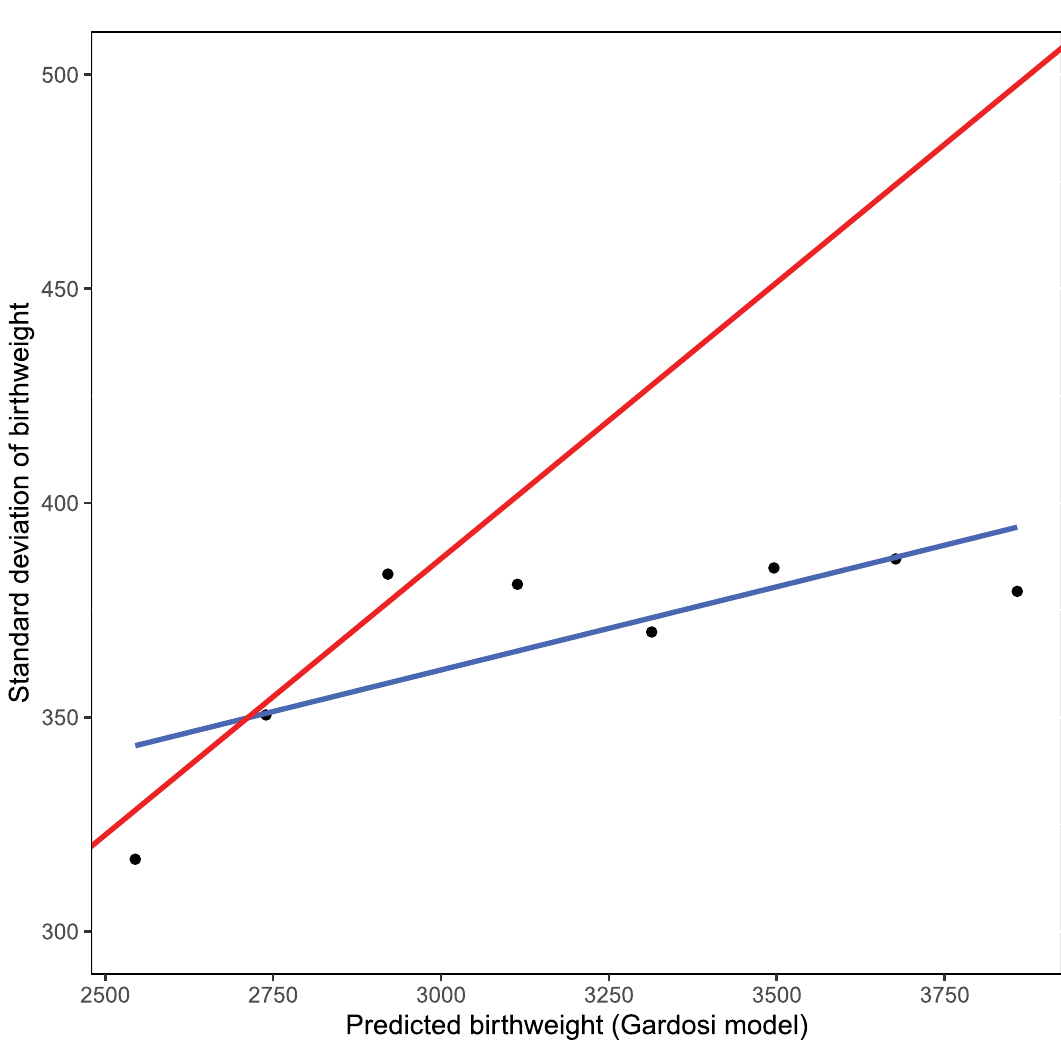
Fig 2. Empirical and Gardosi model based standard deviation of birthweight at different levels of mean birthweight. The constant coefficient variation assumption in Gardosi model would imply the empirical standard deviations would fall along a straight line (red line) with constant CV value as its slope. However, the empirical based fitted line (blue line) differs from the line based on the Gardosi assumption and the empirical points don’t show a linear pattern. Data are from the NICHD Fetal Growth Studies–Singleton. The sample size of each group is 5, 25, 85, 292, 668, 822, 350, and 41 for the point representing the grouped bins from smallest to largest predicted birthweight,